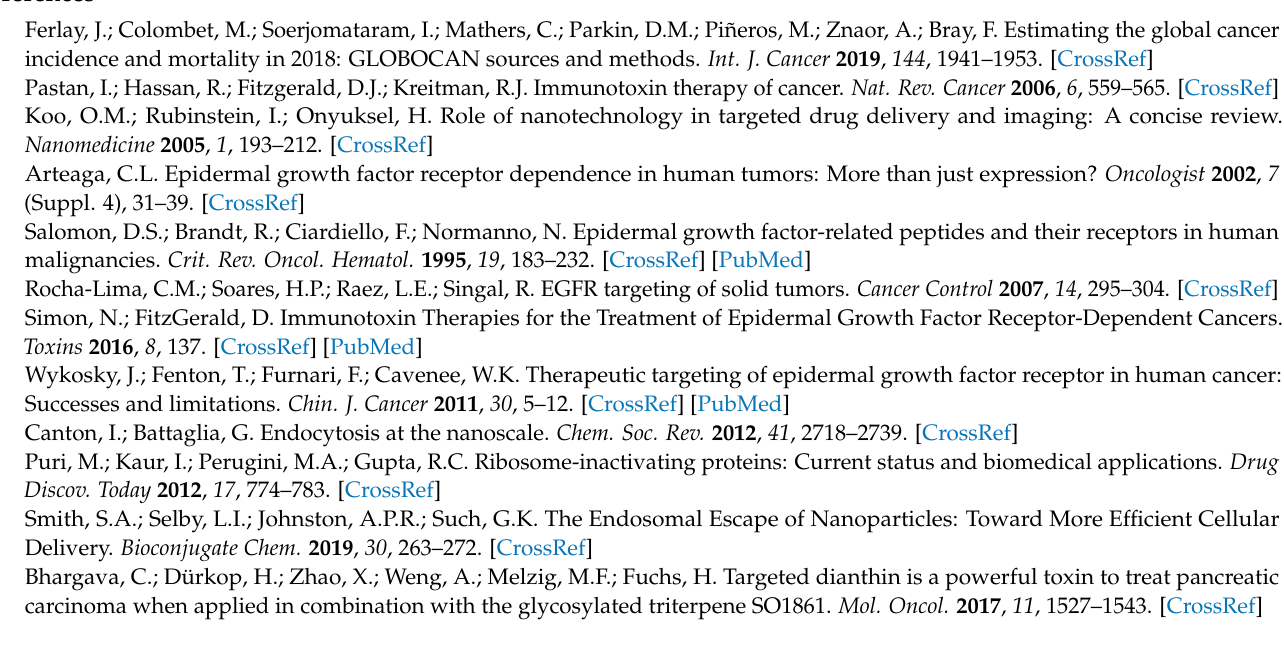
Schematic representation of all modification steps, Figure S2: SDS/PAGE (12%) of the purified frac- tions of Dia and DiaEGF obtained after Ni-NTA and chitin column tandem affinity chromatography, Figure S3: MALDI-TOF-MS spectra of Dia and conjugates with different molar ratios of linker:Dia, Figure S4: MALDI-TOF-MS spectra of DiaEGF and conjugates obtained from different initial molar ratios of linker:DiaEGF in the reaction mixture, Figure S5: XRD-Diffractogram of synthesized SPI- ONs and reference pattern of magnetite/maghemite, Figure S6: FTIR spectra of SPIONs after each functionalization step, Figure S7: DLS measurement of SPION-SO1861 revealing a median size of 84 nm, Figure S8: Cytotoxicity studies of Dia and DiaEGF conjugates on EGFR-overexpressing HCT-116 cells, Figure S9: Self-cytotoxicity of SO1861 on HCT-116. The derived IC50 value accounts for 3.3 µ g/mL, Figure S10: Self-cytotoxicity of SPION-SO1861 on HCT-116. The IC50 value is determined as >1 mM Fe 3+